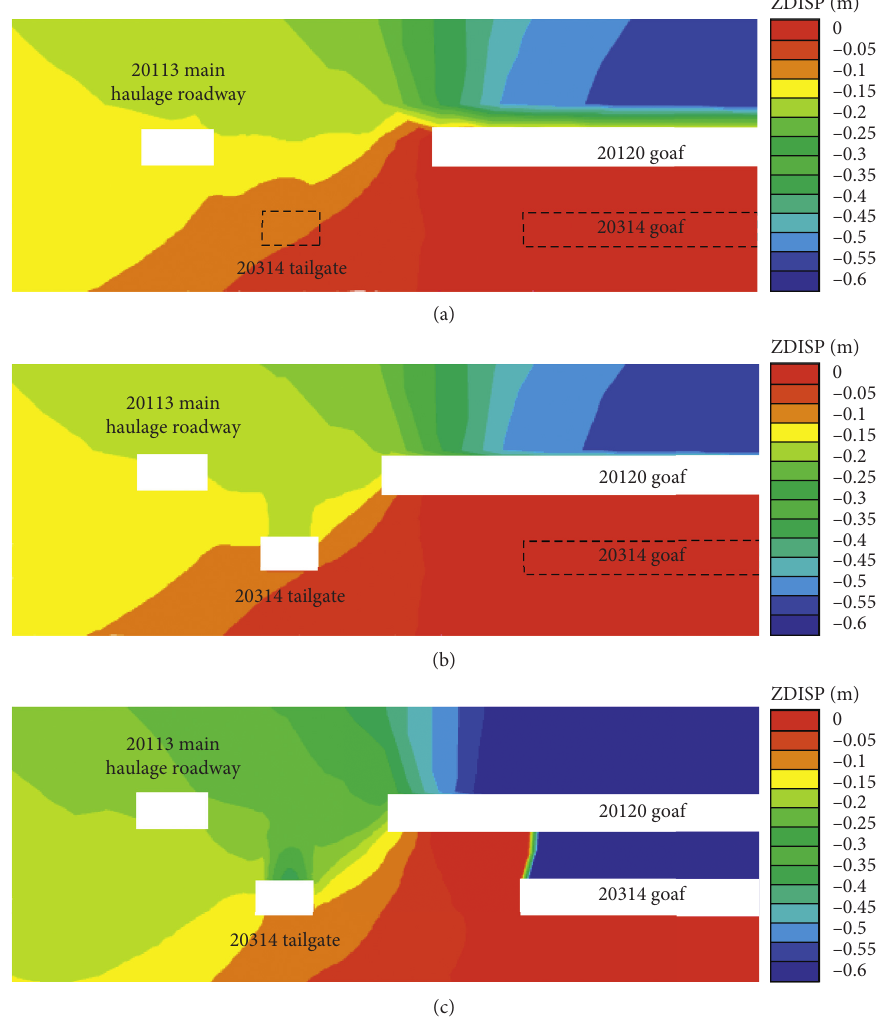
Figure 18: Displacement nephogram perpendicular to the auxiliary haulage roadway (perpendicular to the axis section of the roadway): (a) 2-2 upper coal seam excavation; (b) 20314 tailgate excavation; (c) 20314 panel